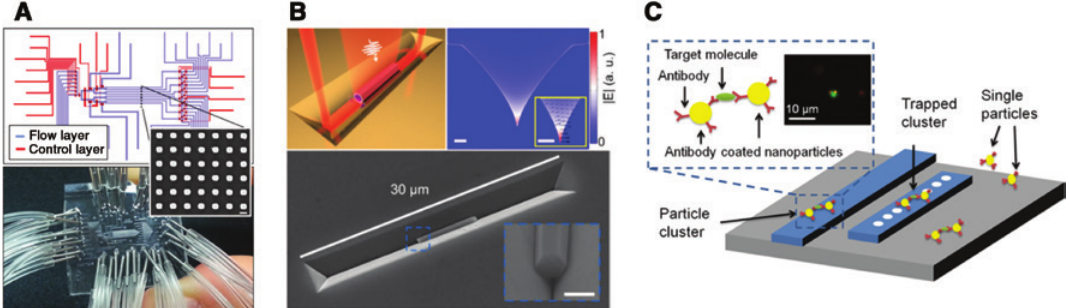
Figure 6: Arrayed and integrated plasmonic nanostructures. (A) Schematic of the flow and control layers (upper inset) in a microfluidic chip (lower inset) that permit parallel LSPR sensing on 32 sensing spots consisting of arrayed nanorods. The inset shows a SEM image of the plasmonic gold sensors, with a scale bar of 200 nm. Adapted from [61]. (B) Hybrid nanowire gold V-groove plasmonic waveguide platform for an on-chip nanolaser source. The upper left panel is a rep- resentative illustration and the upper right panel is the electric field amplitude profile of the fundamental channel plasmon polariton mode supported by the V-groove waveguide at 870 nm. The scale bars here are 300 nm. The SEM angled view image below is of a GaAs/AlGaAs/ GaAs nanowire positioned inside a 30- μ m long V-groove, with a scale bar of 550 nm. Adapted from [62]. (C) Schematic of particle sensing with optical forces to trap and align the particles on waveguide-coupled silicon microcavities. Inset: Fluorescence microscopy image of a cluster with two polystyrene particles bound by green fluorescent protein. Adapted from